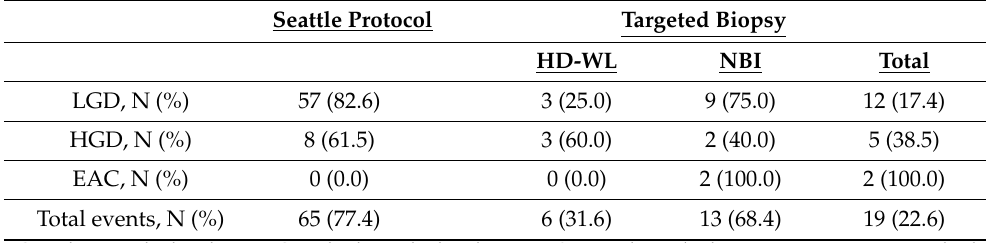
Table 3. Incidence of dysplasia (N = 84) stratified by biopsy type and dysplasia